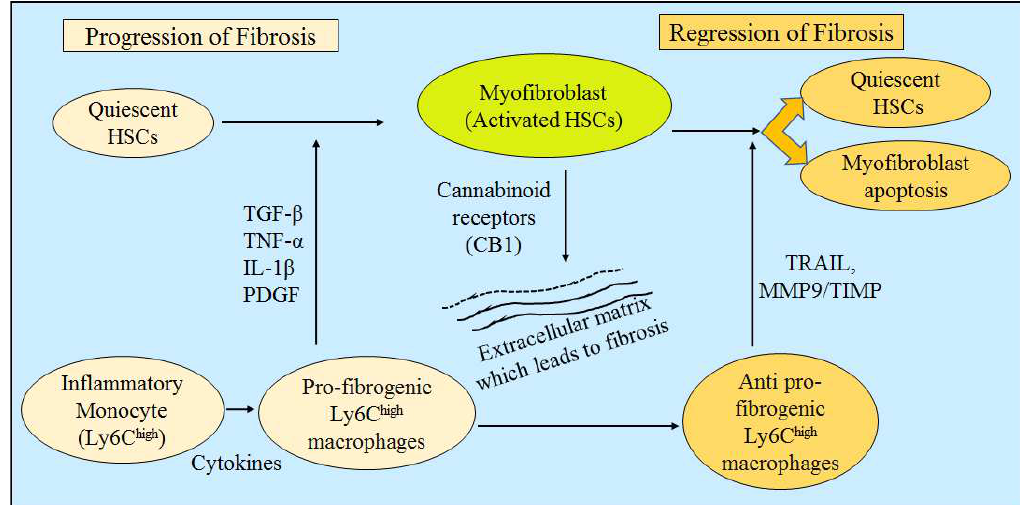
Figure 2. Illustrative representation indicating the interaction between hepatic stellate cells and macrophages during liver fibrosis progression and regression. HSC: hepatic stellate cell, PDGF: platelet-derived growth factor, TGF-β1: transforming growth factor-β, TNF- ɑ : tumor necrosis factor- ɑ , TRAIL: tumor necrosis (TNF)-related apoptosis-inducing ligand; TIMP: tissue inhibitors of metalloproteinases.